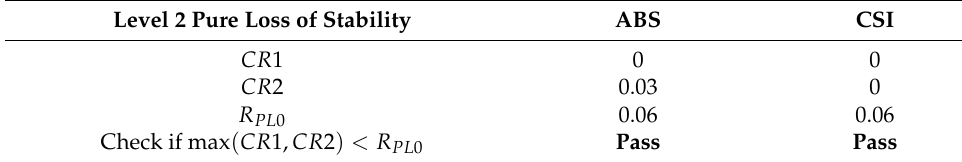
Table 10. Level 2 assessment of the pure loss of stability failure mode for